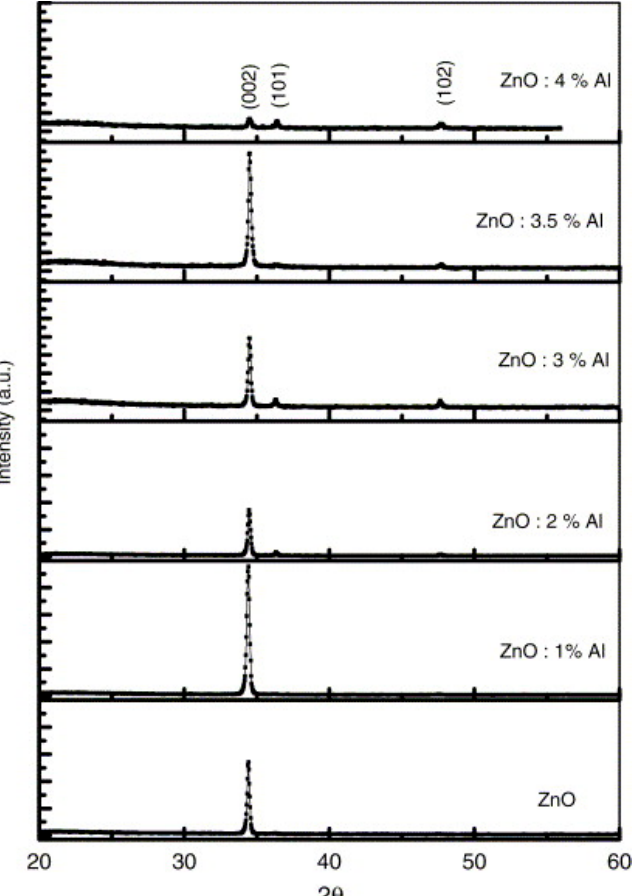
Figure 4. XRD spectra of undoped ZnO and AZO films deposited at 400 °C on quartz substrates for various Al doping concentrations. Reproduced with permission from ref. [50].